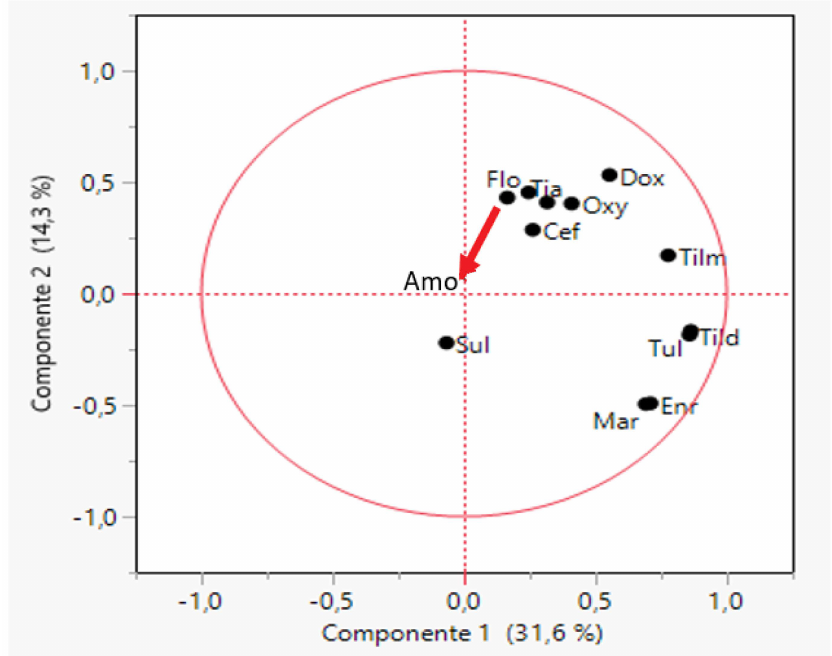
Figure 2. Biplot obtained through a principal component analysis of MIC values for twelve antimicro- bials and 285 strains of Pasteurella multocida (PM). The antimicrobials tested were amoxicillin (Amo), ceftiofur (Ceft), doxycycline (Dox), enrofloxacin (Enr), florfenicol (flo), marbofloxacin (Mar), oxyte- tracycline (Oxy), sulfamethoxazole/trimethoprim (Sul), tiamulin (Tia), tildipirosin (Tild), tilmicosin (Tilm) and tulathromycin (Tul).